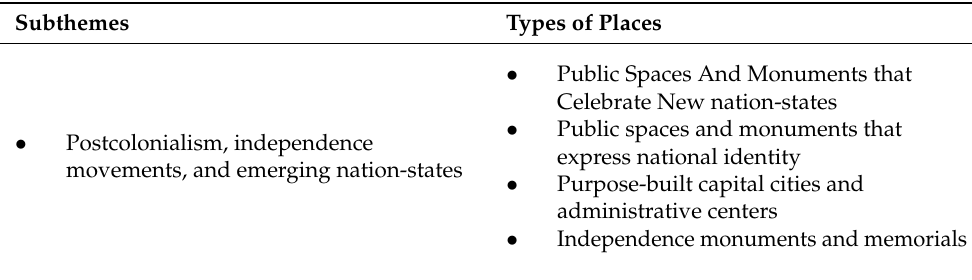
Table 3. Internationalization, New Nation-States, and Human Rights.